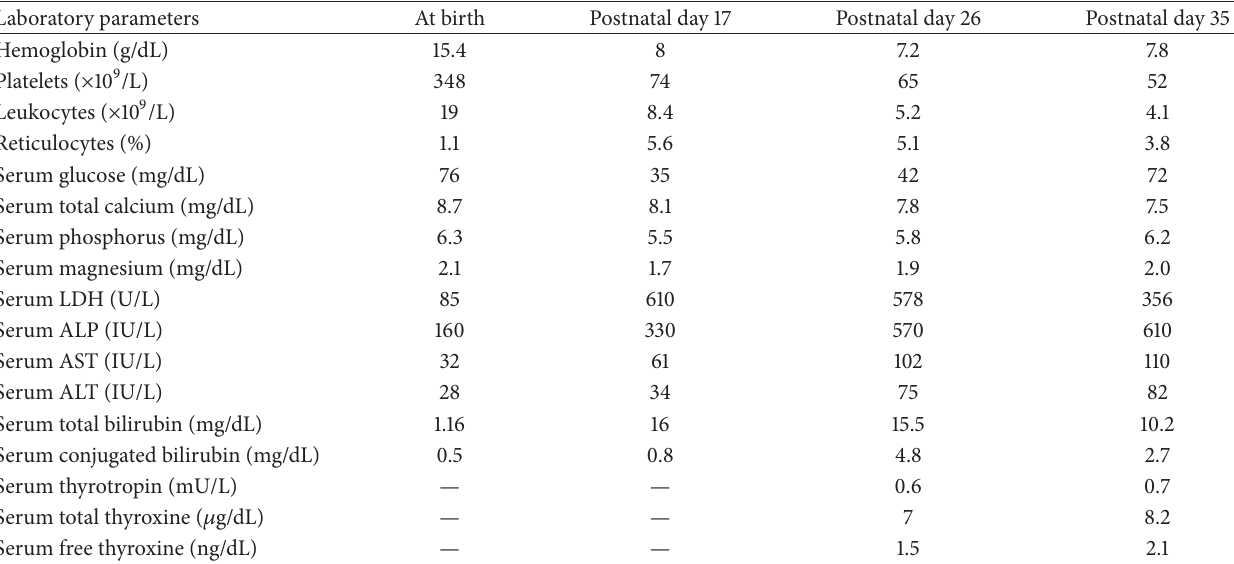
Table 1: Laboratory features with respect to postnatal age.